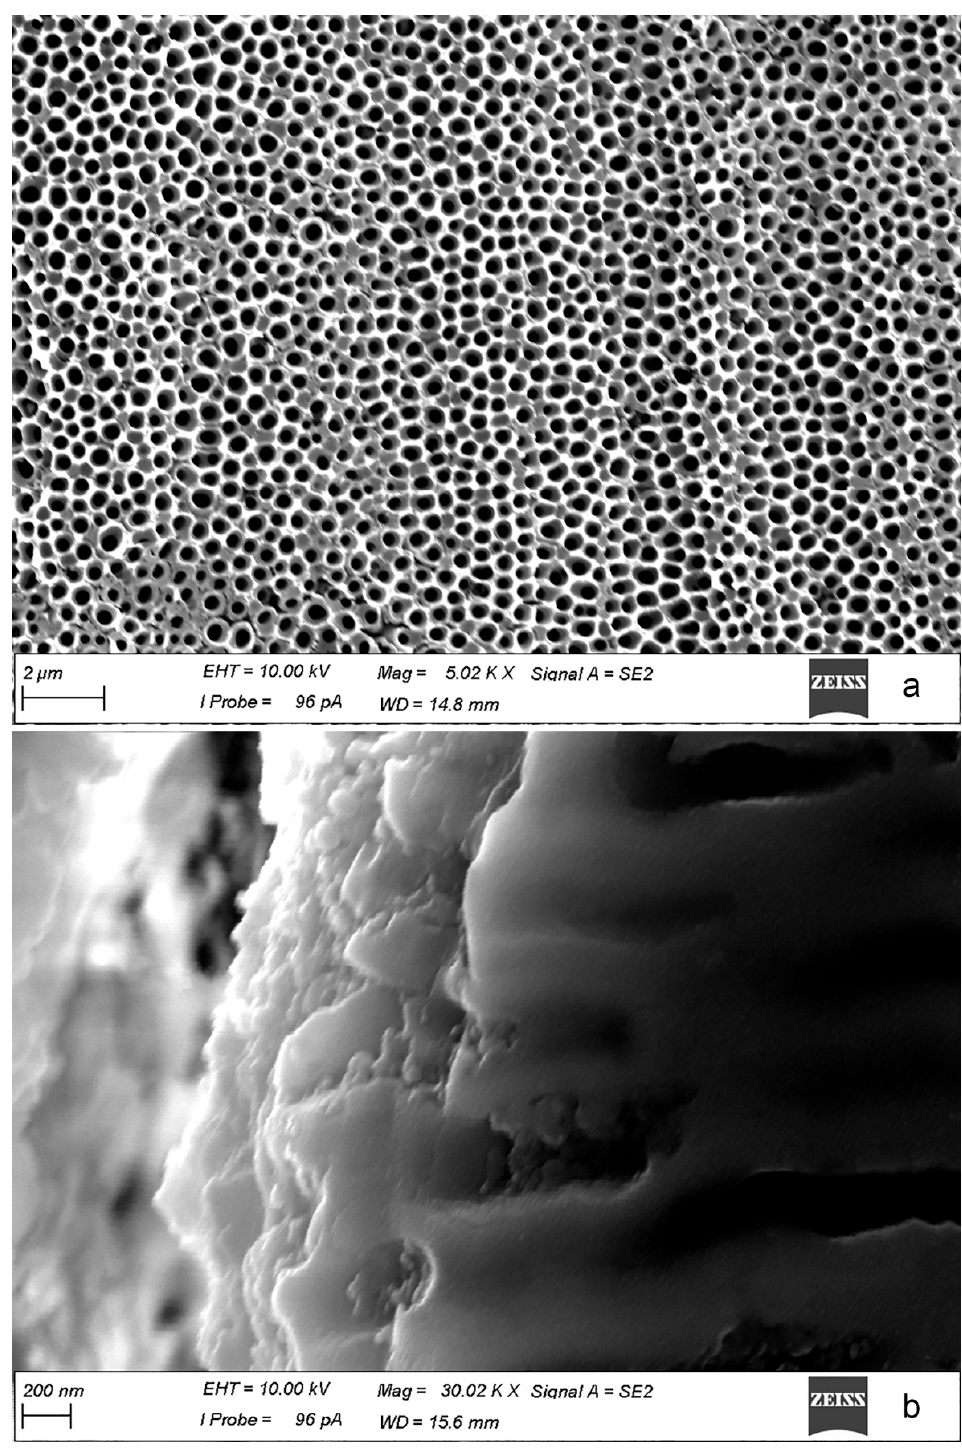
Figure 14. SEM images of the surface ( a ) and cross-section ( b ) of the PEO-coating formed on 1579 Al alloy